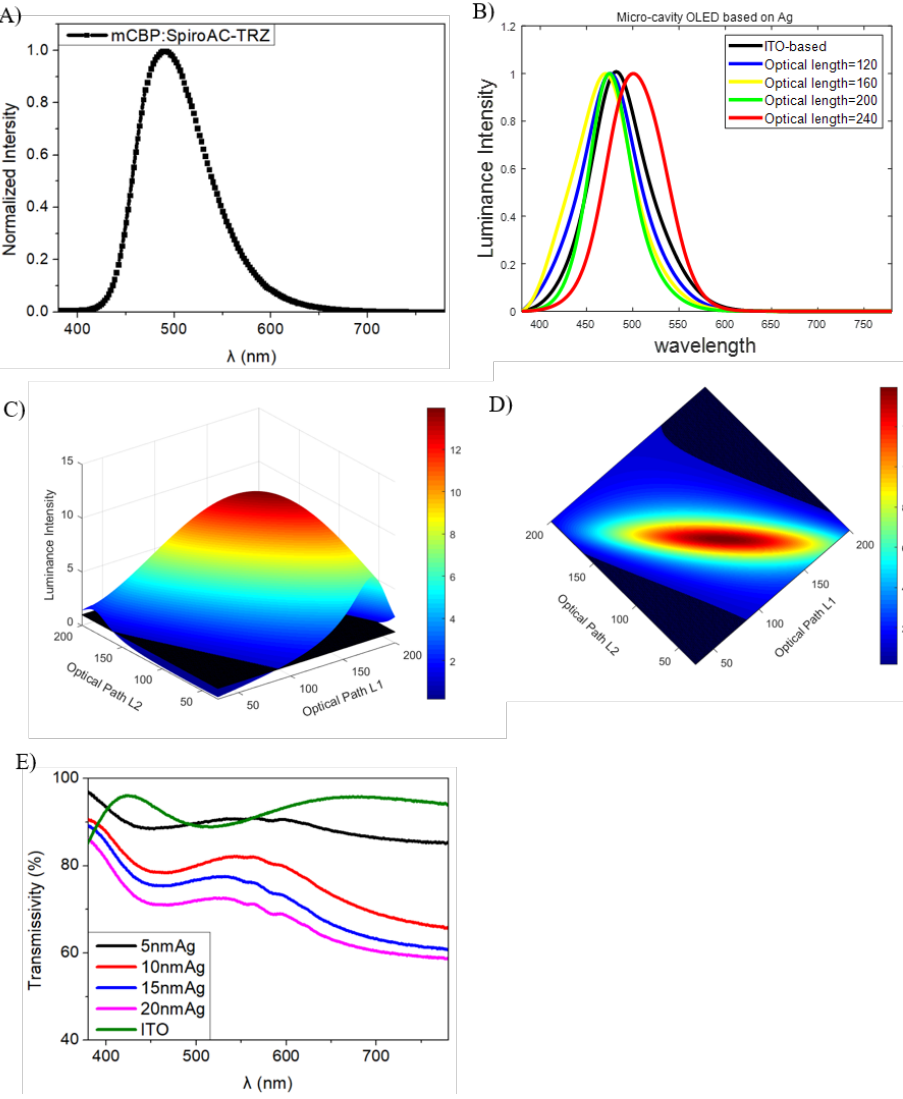
Figure 7. ( A ) PL spectra of mCBP doped with SpiroAC-TRZ, ( B ) Simulated EL spectra of micro-cavity OLEDs at different optical lengths, ( C ) Simulated luminance intensity of 480 nm in micro-cavity OLEDs with different optical paths L1 and L2, contrasted with ITO-based OLEDs ( D ) and its top view, and ( E ) the measured transmissivity of Ag (x nm, x = 5, 10, 15, 20)/ITO and ITO.